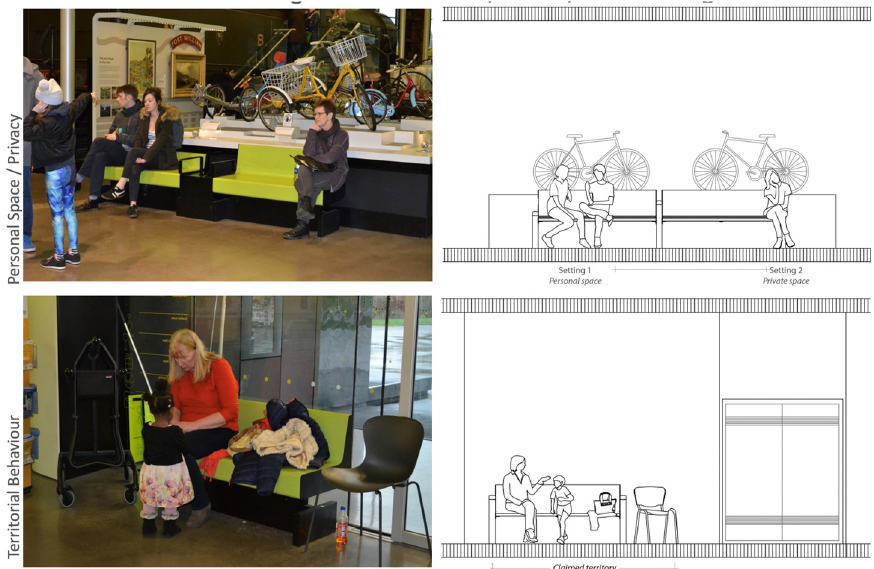
Figure 7. Personal space/privacy and territorial behavior as observed in the two settings within the Riverside Museum. (Photos by A. Salama; drawing by L. MacLean).